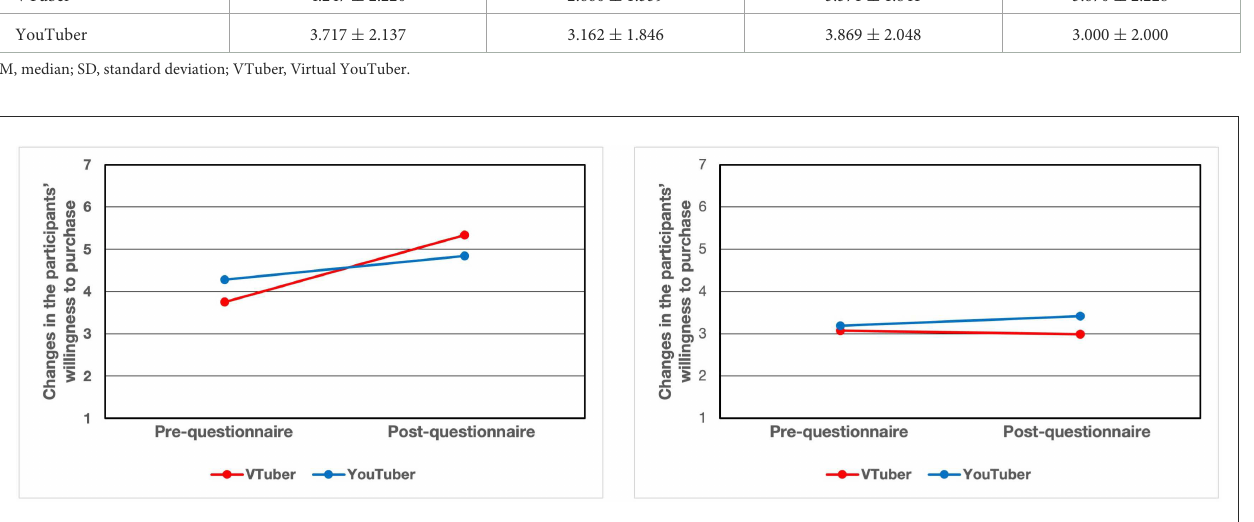
FIGURE2 Effects of the promotional videos by VTubers (virtual YouTubers) and YouTubers on participants’ willingness to